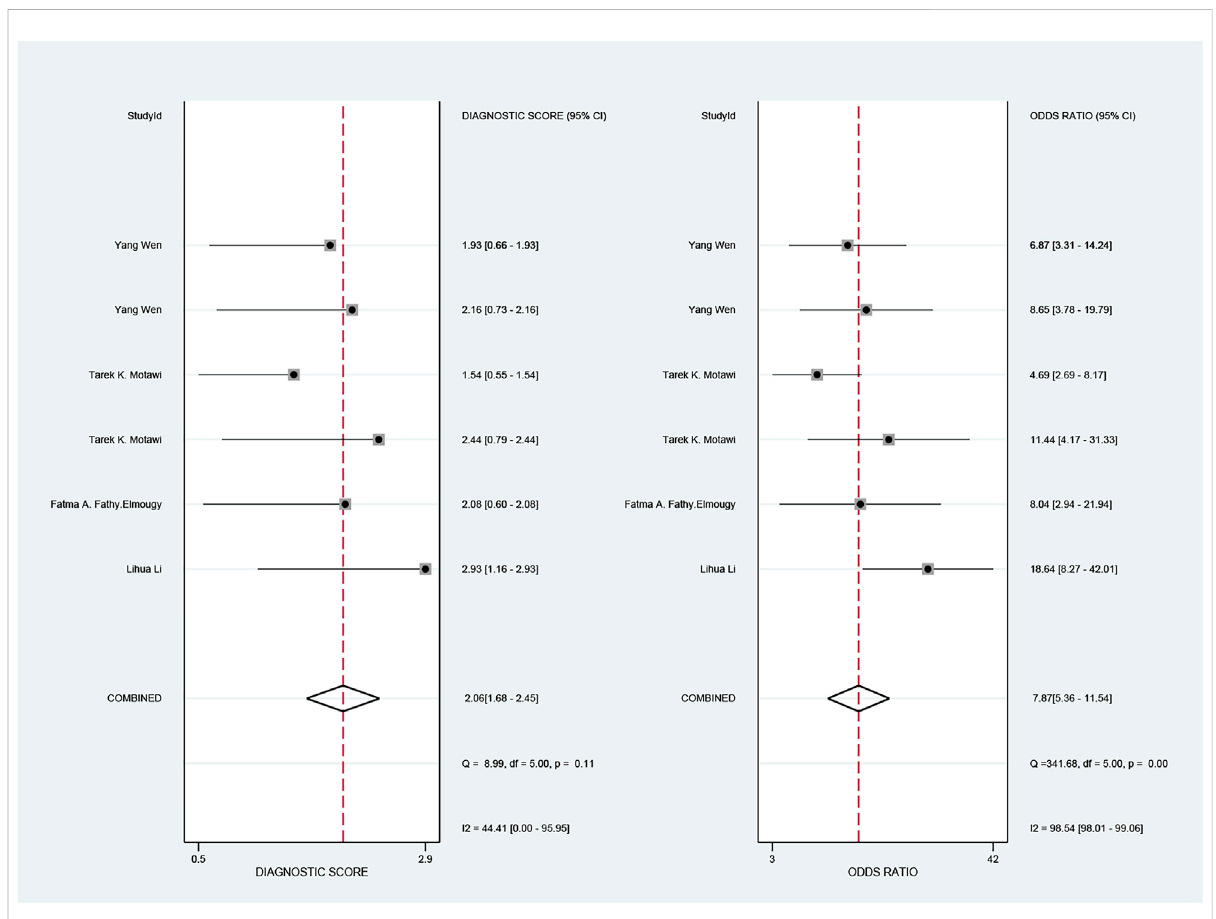
FIGURE 4 Forest plot of the diagnostic odds ratio (DOR) for the miR-17 – 92 cluster in the diagnosis of hepatocellular